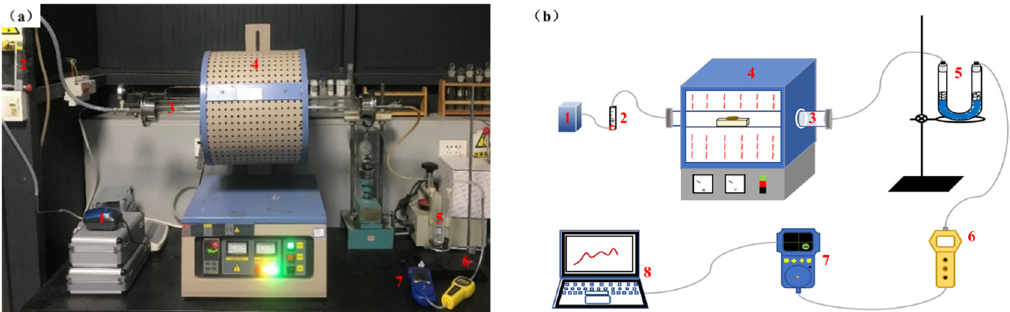
Figure 2. Sulfur-containing gas detection test bench: ( a ) Combustion and sulfur-containing-gas detection device diagram; ( b ) combustion and sulfur gas detection diagram; 1-air pump; 2-rotor flow meter; 3-quartz tube; 4-tube furnace; 5-U-tube; 6-suction pump; 7-gas detector; 8-computer.